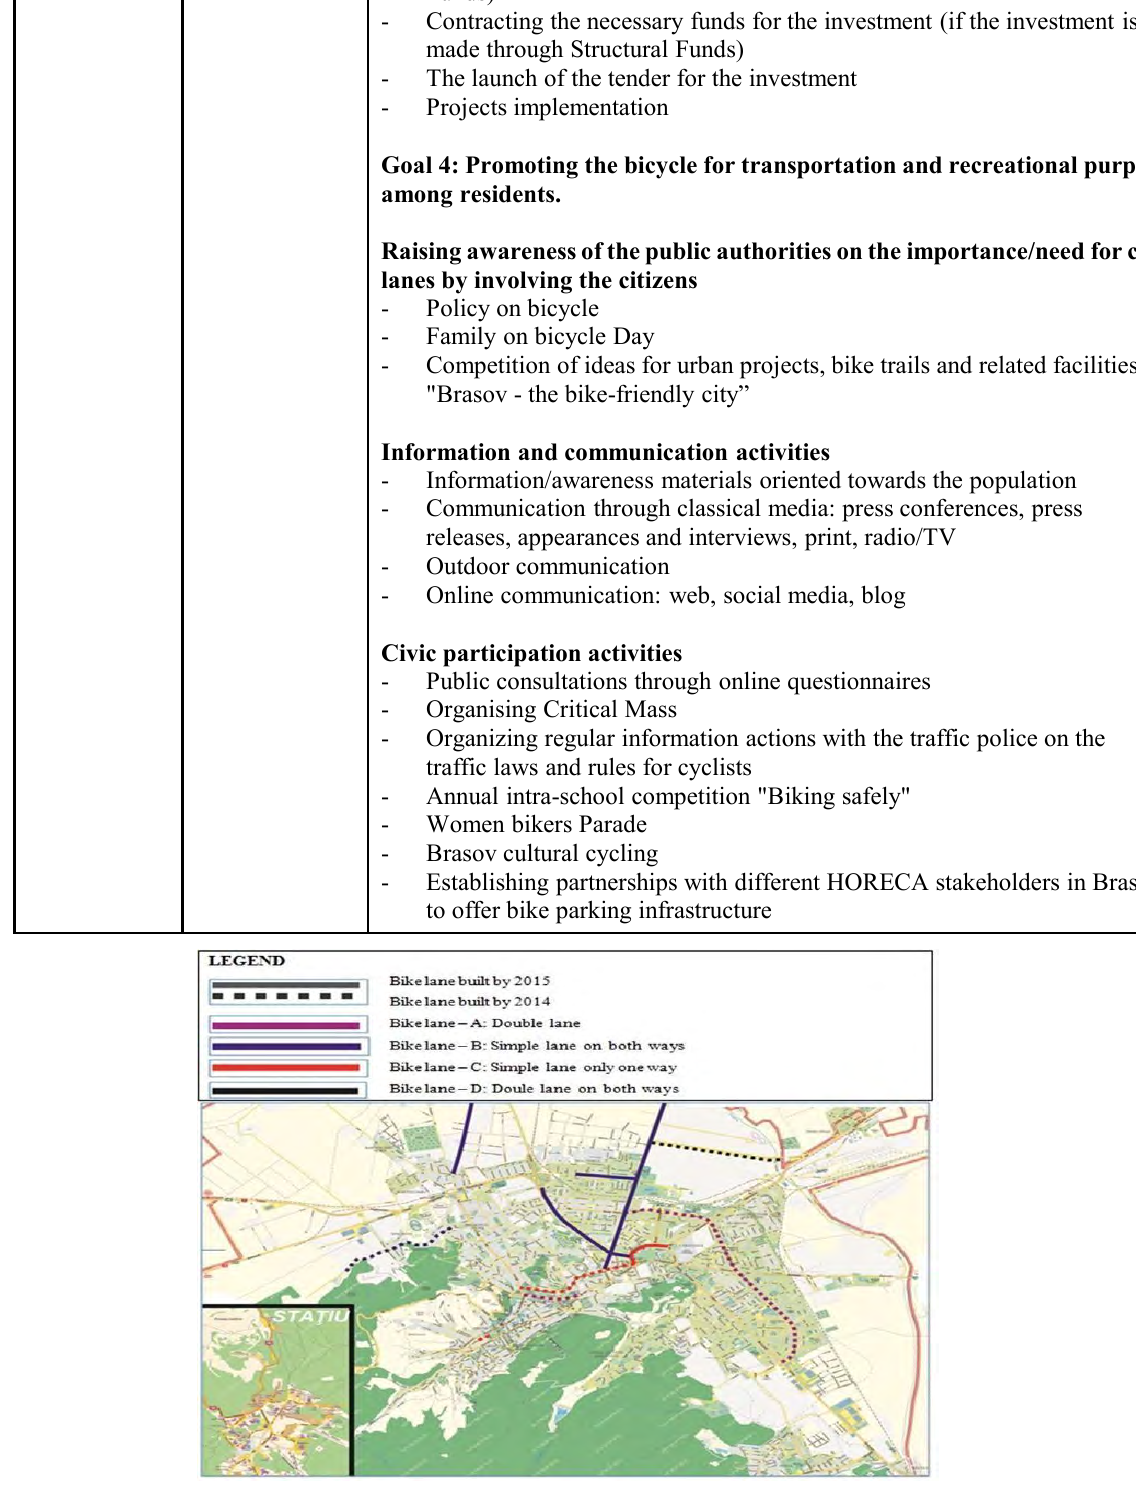
Figure 3 – Brasov’s bike lane